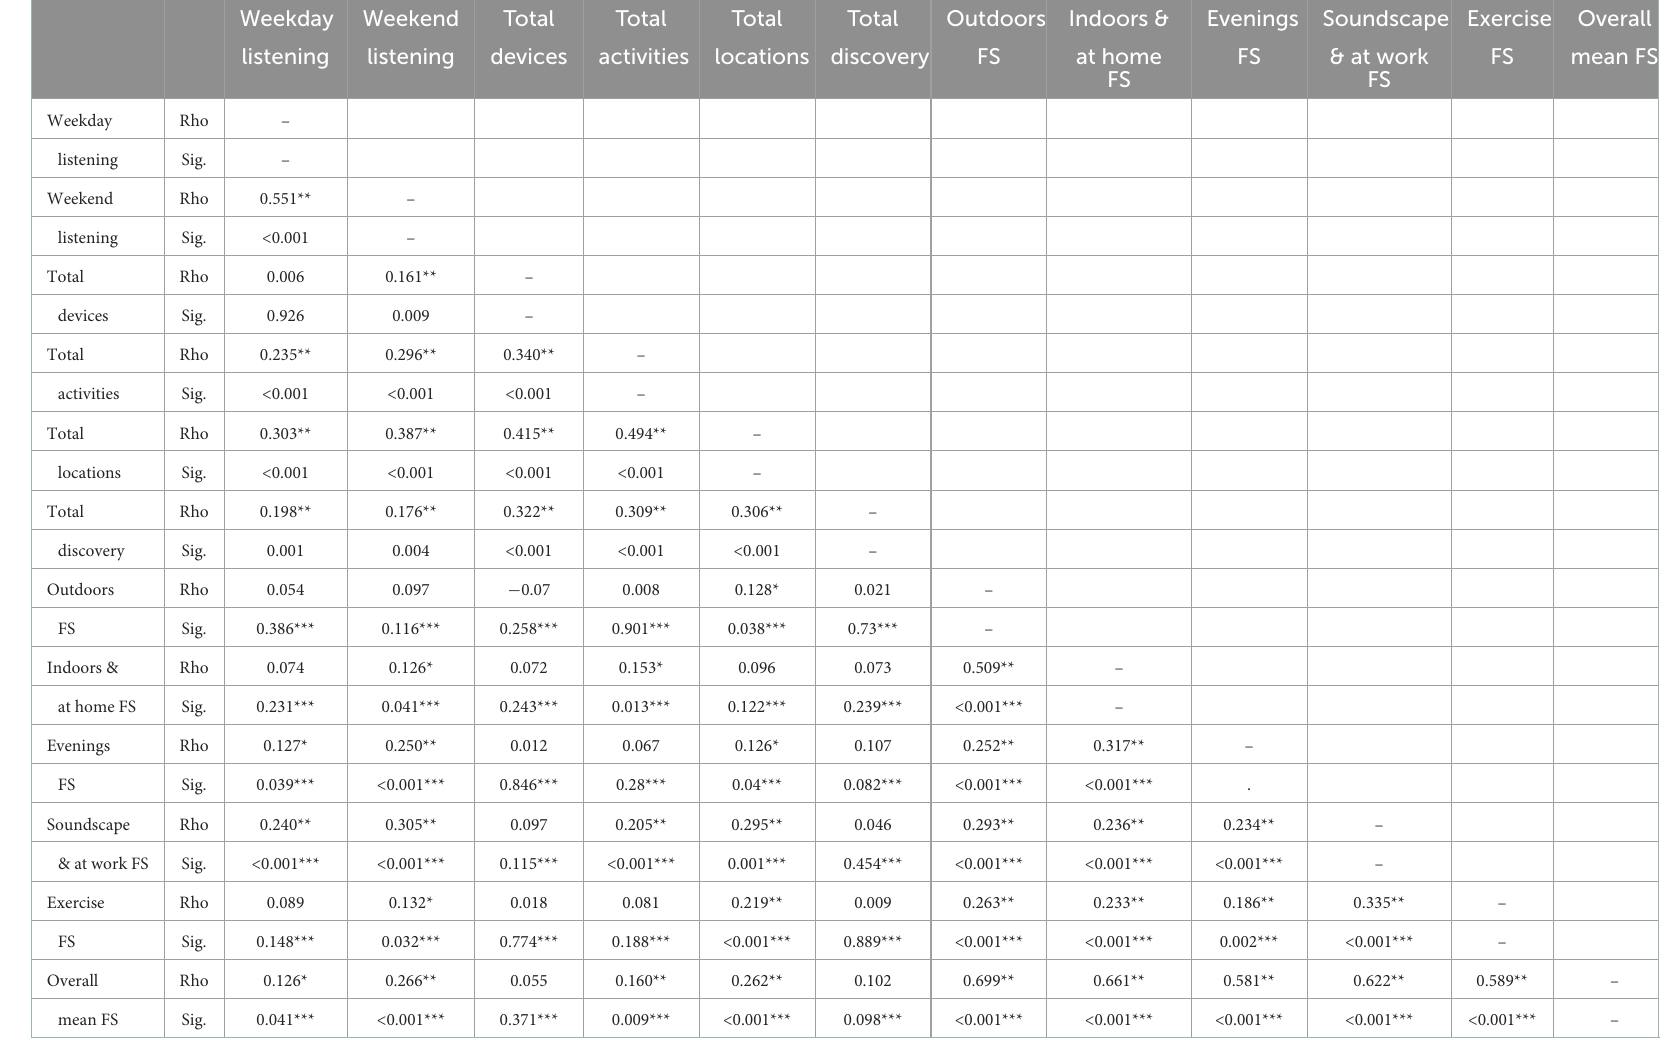
TABLE 11 Spearman’s rank-order correlations amongst the aspects of podcast listening engagement & environmental context factor scores ( N =